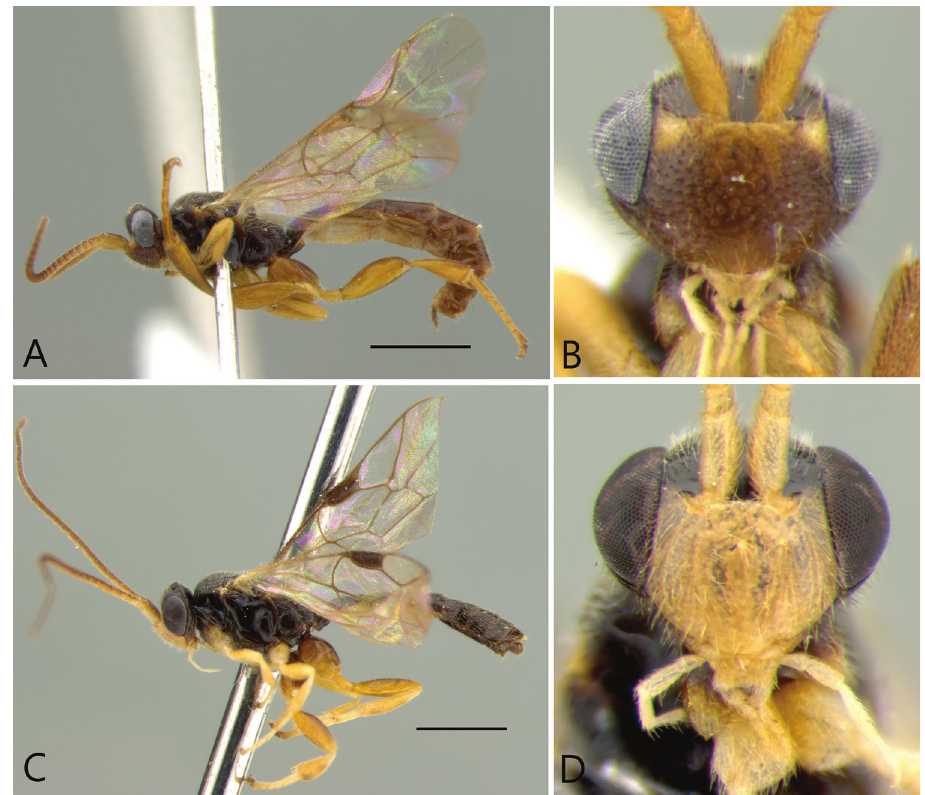
Figure 19. Orthocentrus spp. A Habitus in lateral view of O. stigmaticus B head in frontal view of O. stig- maticus C habitus in lateral view of male of O. winnertzii D head in frontal view of male of O. winnertzii